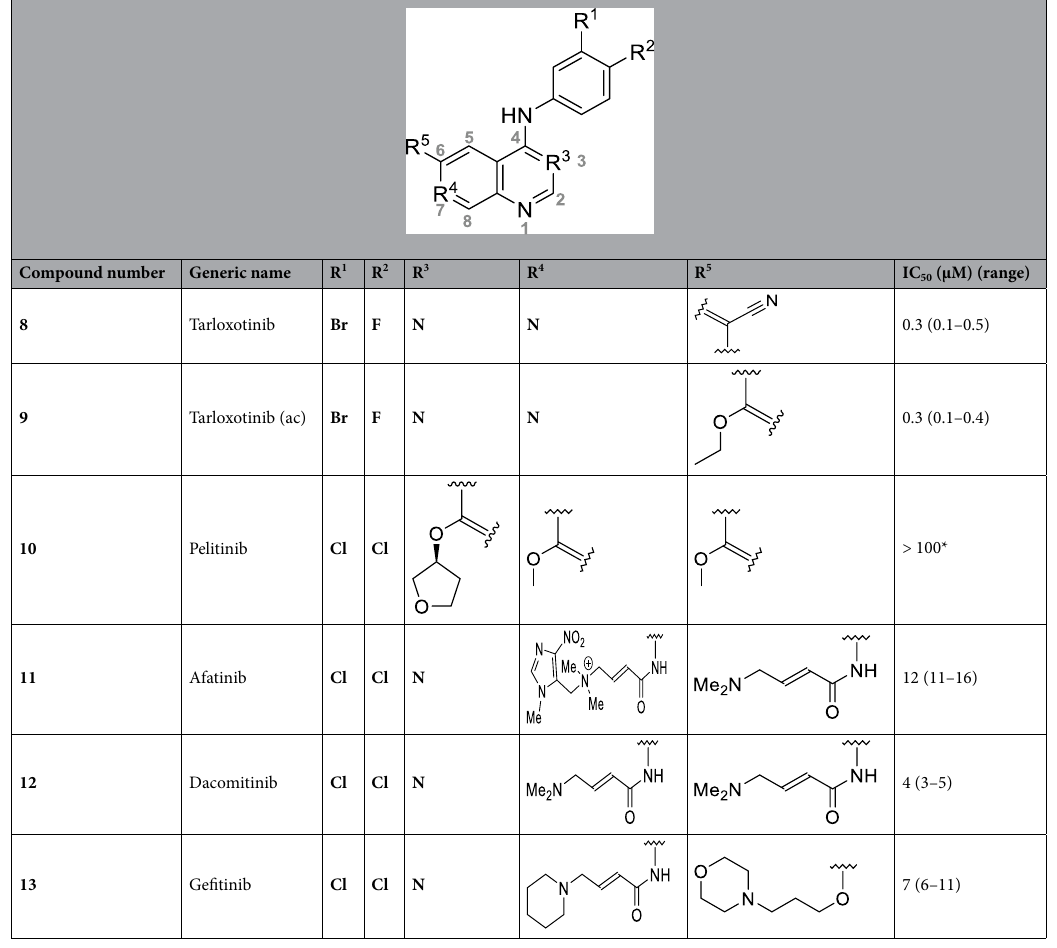
Table 1. Structure–activity relationship of 4-aminoquinazoline EGFR inhibitors against SARS-CoV-2 PL pro . *The range could not be established due to lack of